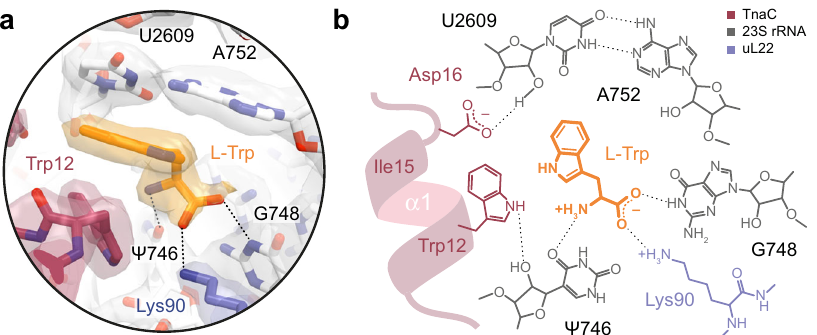
Fig. 4 The TnaC – ribosome complex captures a single L-Trp molecule. a Close-up of the L-Trp-binding site, showing the models and corresponding densities for the TnaC(R23F) peptide (red), L-Trp (orange), 23S rRNA (white), and ribosomal protein uL22 (periwinkle blue). The L-Trp ligand is wedged between residue Trp12 of TnaC and the 23S rRNA base pair A752:U2609, with which it makes a π – π stacking interaction. Segmented densities for the ribosome, TnaC, and L-Trp are shown using the same contour level. b Chemical diagram showing the binding of the L-Trp ligand. The backbone of the L-Trp ligand makes hydrogen bonds with the bases of 23S rRNA residues Ψ 746 and G748, and a salt bridge with residue Lys90 of ribosomal protein uL22.